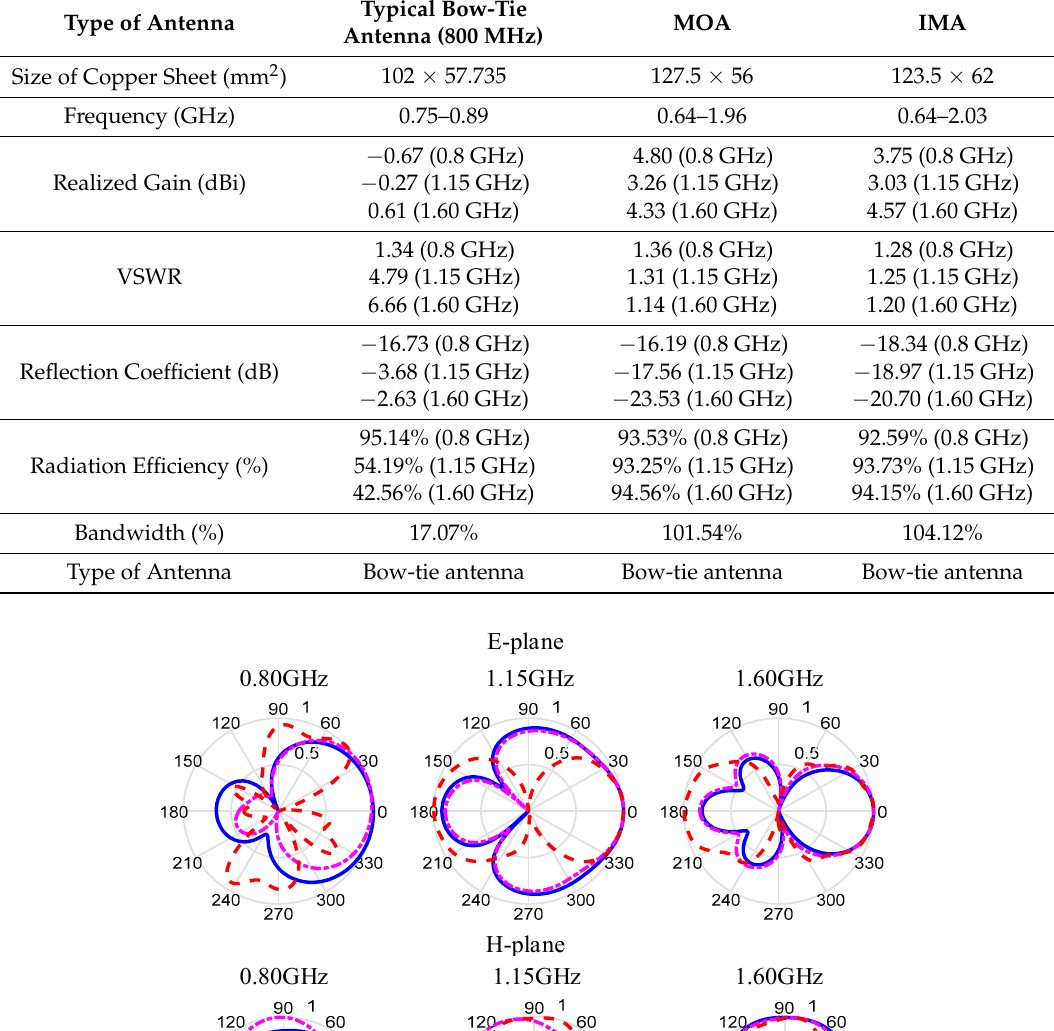
Table 2. The simulated performances of typical Bow-tie antenna, MOA, and IMA.